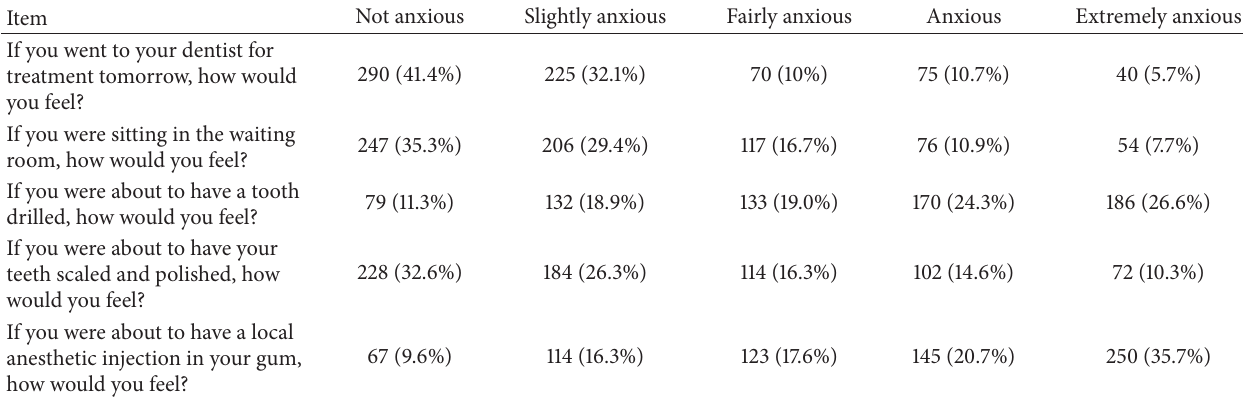
Table 4: The distribution of participants according responses to the items of Modified Dental Anxiety Scale ( 𝑛 = 700